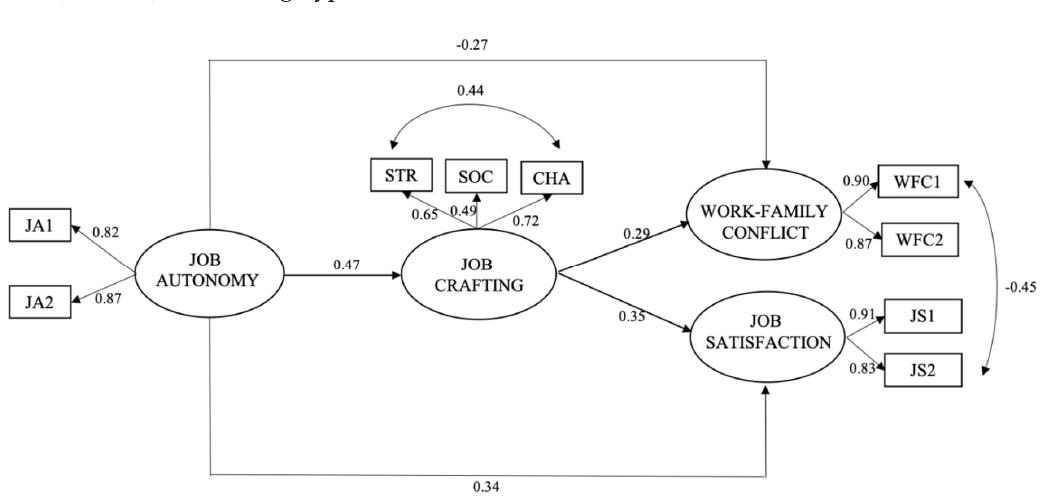
Table 3. Indirect effects of the estimated SEM using